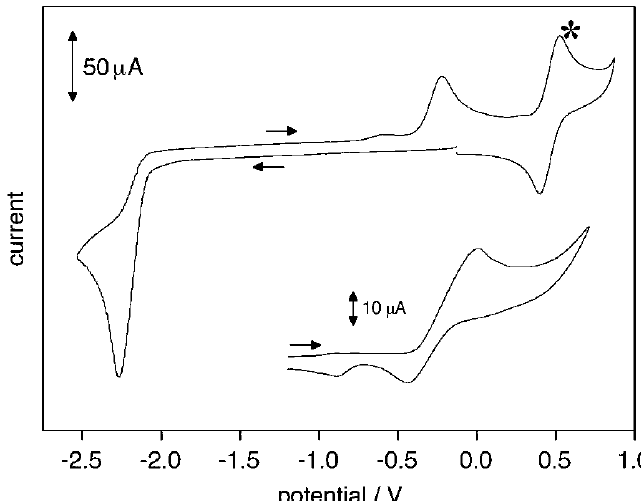
Figure 4. Cyclic voltammetry of 1,3-bis(2,4,6-trimethylphenyl)imidazolium chloride in DMF. Arrows define the scan direction. Reproduced with permission from [27]. Copyright The Royal Chemical Society, 2004.